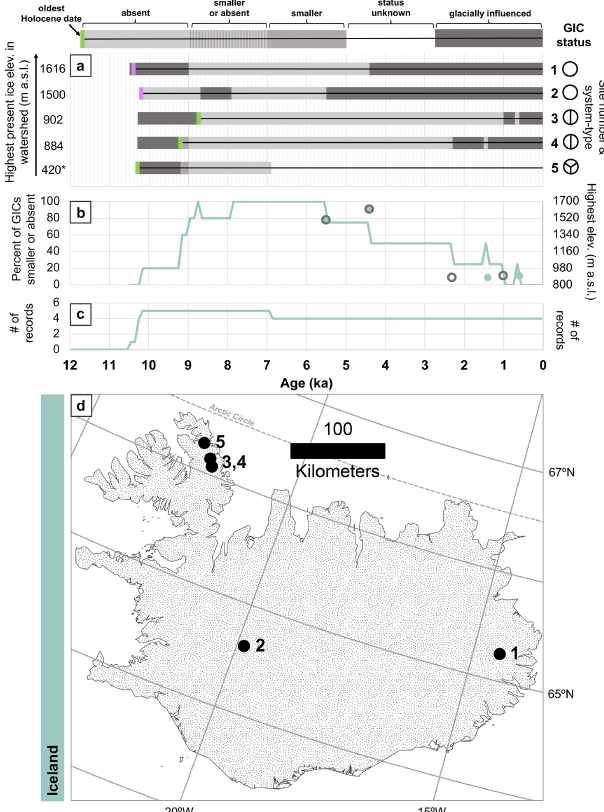
Figure 6. Holocene lake-based GIC records from Iceland. Panel descriptions, symbols, and colors are the same as in Fig. 3. Sites are as follows: 1. Striberger et al. (2012) (Lake Lögurinn, Ey- jabakkajökull Glacier); 2. Larsen et al. (2012) (Lake Hvítárvatn, Langjökull Ice Cap); 3. Harning et al. (2016a, b) (Tröllkonuvatn Lake, Drangajökull Ice Cap); 4. Harning et al. (2016a, b) (Efra– Eyvindarfjarðarvatn Lake, Drangajökull Ice Cap); 5. Harning et al. (2016a) (Skorarvatn Lake, Drangajökull Ice Cap). We note that records 3, 4, and 5 are considered threshold lake records. Thus, the non-glacial–glacial transitions may not precisely represent the tim- ing of the ice cap’s response to climate forcings. ∗ At present, Sko- rarvatn Lake is outside the Drangajökull Ice Cap’s drainage area and 420ma.s.l. is the reported catchment threshold for receiving glacial